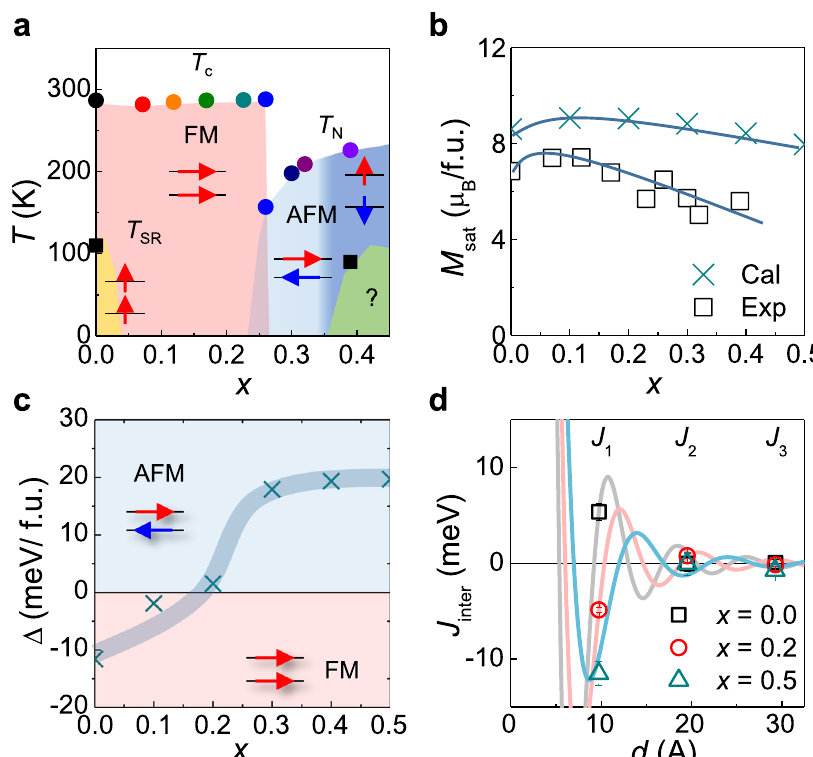
Fig. 3 First-principles calculations of (Fe 1 − x Co x ) 4 GeTe 2 . a Phase diagram of spin states for (Fe 1 − x Co x ) 4 GeTe 2 with Curie ( T C ) and Neel ( T N ) temperatures. Four different spin states in terms of interlayer spin con fi gurations (FM and AFM) and spin orientations (easy-axis and easy-plane) are stabilized depending on doping level and temperature. The unknown magnetic phase is found for x = 0.39 below T = 90 K. The schematic illustration of spin con fi gurations is shown in the inset. b The saturation magnetization M sat (square symbol) and the calculated M sat (cross symbol) as a function of Co doping x . c Doping-dependent total energy difference Δ between the FM and the A-type AFM phases. The FM-to-AFM transition occurs at the critical doping level x c ~ 0.2, in good agreement with experiments. d Calculated interlayer exchange interaction J inter with different layer distance ( d ) for x = 0, 0.2, and 0.5. The oscillatory dependence of J inter ( d ), captured by the RKKY model, is systematically changed with Co doping. The errors in the experimental data are smaller than the size of the